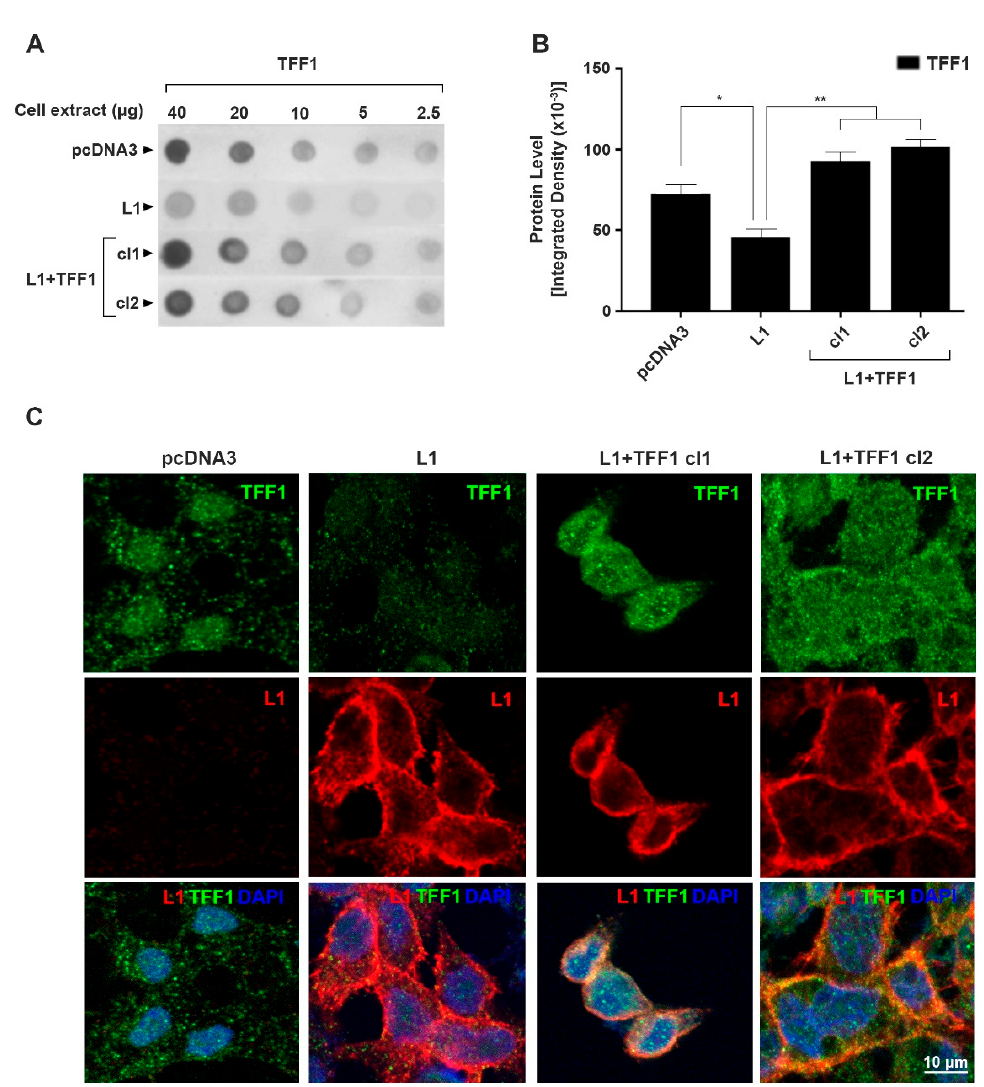
Figure 2. Isolation and localization of L1 and TFF1 in CRC cell clones overexpressing both L1 and TFF1. ( A ) Serial dilutions of cell extracts analyzed by immuno-dot-blotting using LS 174T CRC cell clones overexpressing both L1 (L1) and TFF1 (L1 + TFF1 cl1 and cl2); ( B ) densitometric analysis of the dot blots shown in ( A ); ( C ) localization of L1 and TFF1 in CRC cell clones overexpressing both L1 (red) and TFF1 (green) by double immunofluorescence microscopy. Nuclei were stained with DAPI (blue). * p < 0.05, ** p < 0.01. The uncropped blots are shown in Supplementary File S1.